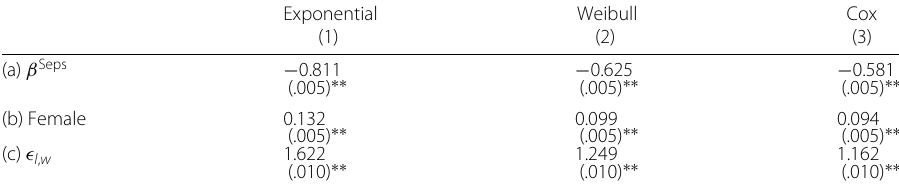
Table 3 Elasticity estimates, by various hazard specification Exponential